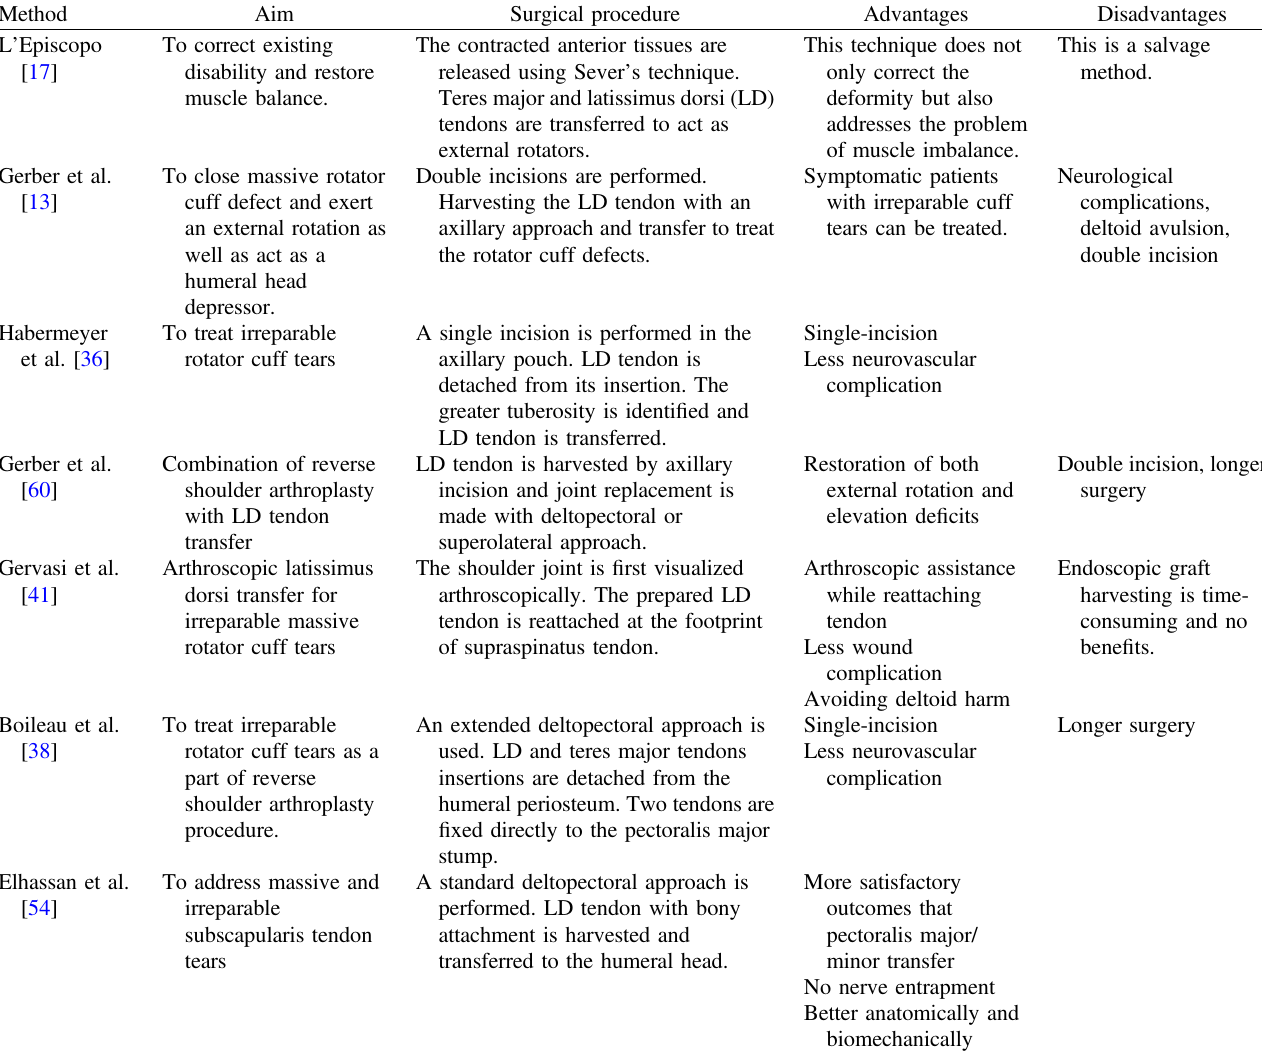
Table 1. Latissimus dorsi tendon transfer techniques.